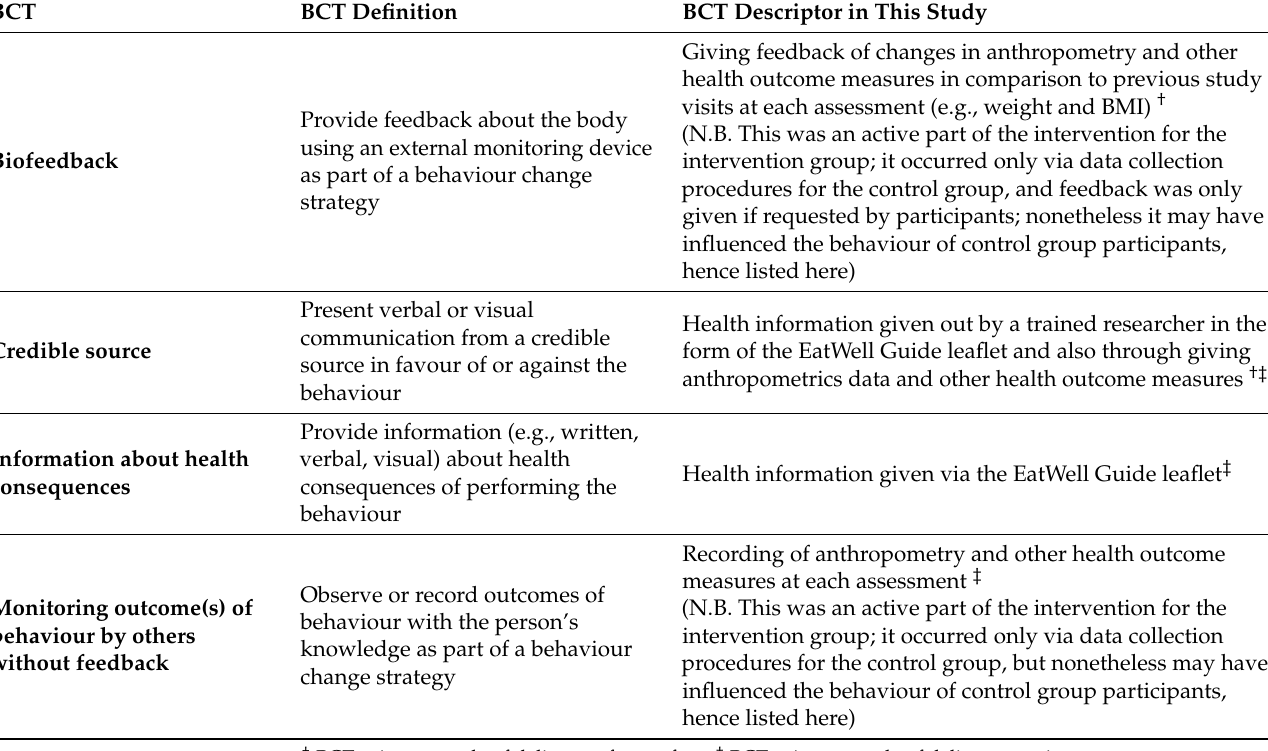
Table 1. BCTs for Intervention and Control Groups using the 93 Item V1 Taxonomy.